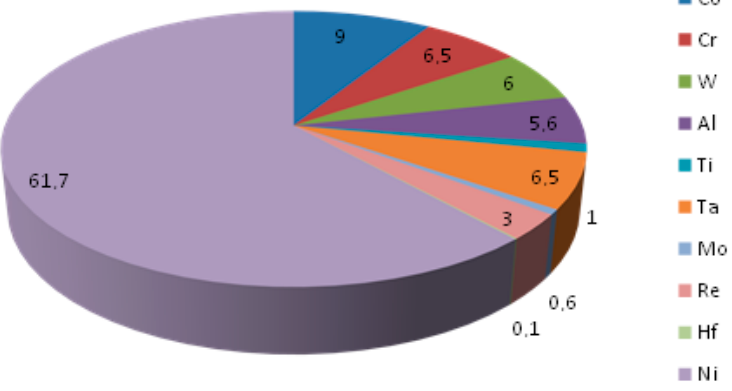
Figure 1. Pie chart representation of CMSX-4 chemical composition (wt %).